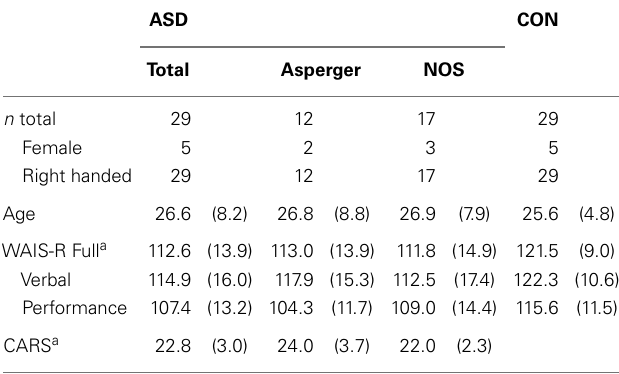
Table 1 | Mean (with SD) background information of subjects